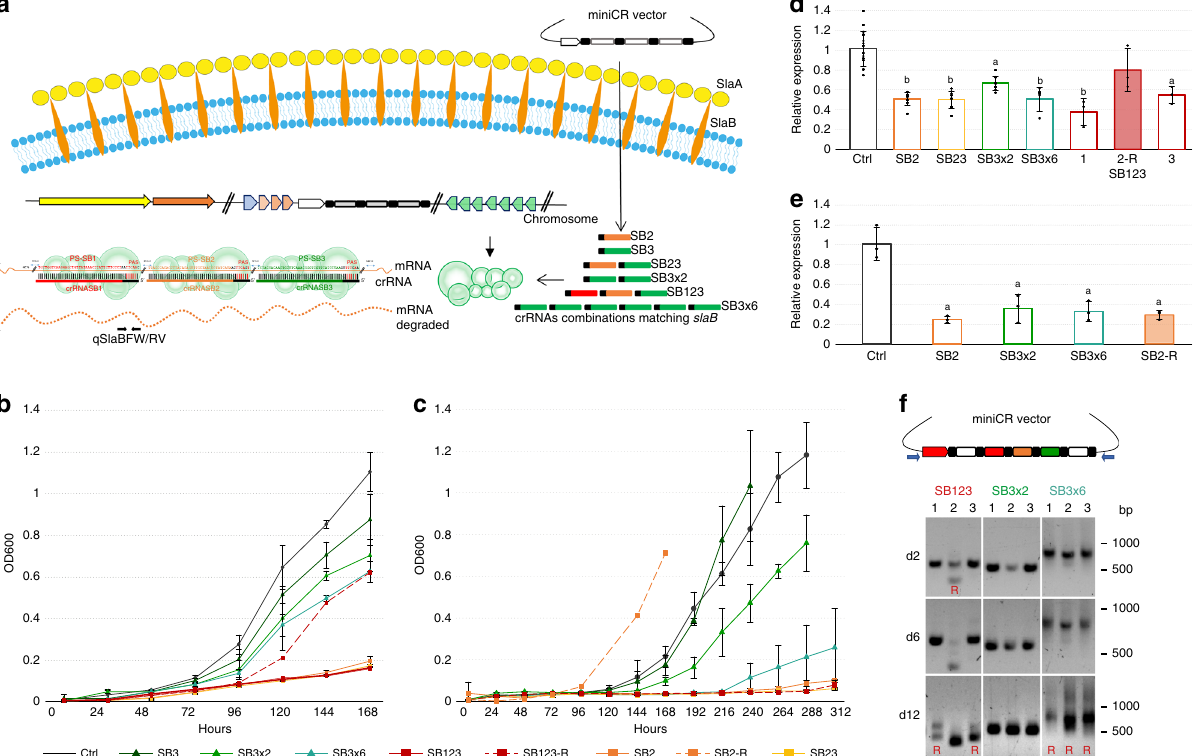
Fig. 1 Silencing of slaB in S. solfataricus . a Schematic representation of the type III silencing pathway used for slaB knockdown. CrRNA assortments expressed from different miniCRISPRs in trans target the slaB mRNA at three possible positions (i.e., protospacer PS1, 2 or 3), each carrying a 3 ′ protospacer adjacent sequence (PAS). Protospacer positions (measured from start codon) and RT-qPCR — primer binding site are indicated (qSlaBFW and qSlaBRV). b Optical density increase of pDEST-SB-silenced cultures and pDEST-Ctrl control cultures (without targeting spacer). SB123-R represents a reverted (R) culture, which has lost the targeting spacer (cf. Fig. 1d and f). Dark gray (circle): control; dark green (triangle): SB3; green (triangle): SB3×2; petrol (triangle): SB3×6; red dash (rectangle): SB123 replicates; red dashed (rectangle) SB123-R; orange (rectangle): SB2; yellow (rectangle): SB23. Error bars, mean ± SD ( n = 3, i.e., three different plaques picked and inoculated into liquid medium). c Optical density increase of pIZ-SB-silenced primary cultures and pIZ-Ctrl control cultures. Dashed orange line (SB2-R) represents a reverted (R) miniCR-SB2 culture, which arose by mutation of the targeting spacer upon culture transfer (cf. Fig. 1e). Color code/line markers and SD are de fi ned as in b . d RT-qPCR on total RNA extracts of pDEST-SB-silenced cultures harvested at OD 600 = 0.1. SlaB mRNA was quanti fi ed by qSlaBFW and qSlaBRV primers relative to the reference gene SSOP1_3283 (glyceraldehyde-3-phosphate dehydrogenase); Filled bars = reverted culture (R) (cf. 1c); Lower case letters indicate signi fi cant differences to Ctrl (two- tailed t test, n ≥ 3, p ≤ 0.007). Error bars, mean ± SD (at least three biol. and tech. replicates). e RT-qPCR on total RNA extracts of pIZ-SB-silenced cultures at OD 600 = 0.1. SlaB mRNA was quanti fi ed by qSlaBFW and qSlaBRV primers relative to the reference gene SSOP1_3283 (gapN-3); Filled bars = reverted culture (R); Lower case letters indicate signi fi cant differences to Ctrl (two-tailed t test, n = 3, p ≤ 0.0137); Error bars, mean ± SD (three biol. replicates). f PCR products ampli fi ed by virus vector-backbone primers (blue) of pDEST – SB123, SB3×2, and SB3×6 transformants sampled at 2, 6, and 12 days after plaque inoculation, respectively. Three biol. replicates shown (1,2,3). Double bands and smears indicate loss of targeting spacers. Positions of DNA ladder are indicated (bp). Source data are provided